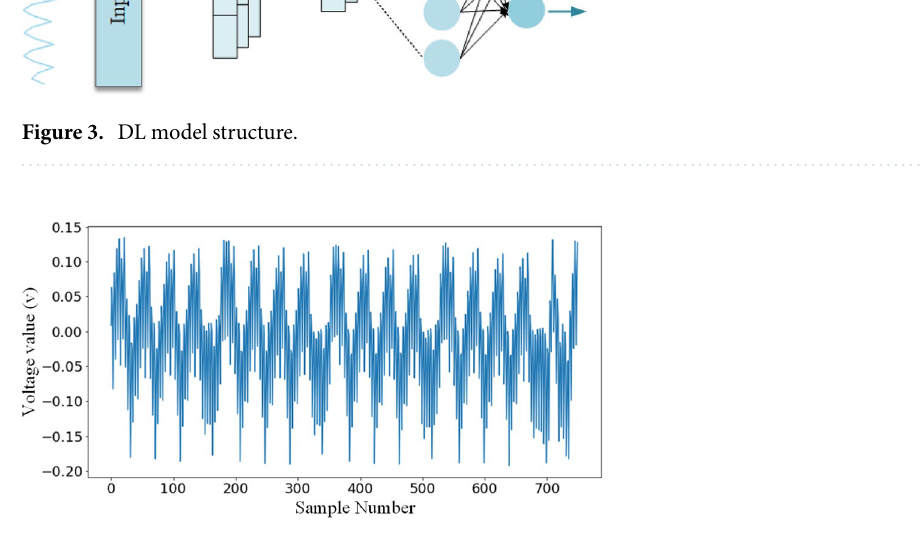
Figure 4. Waveform of the first round traces of the STM32F3 implementation of TintAES-128